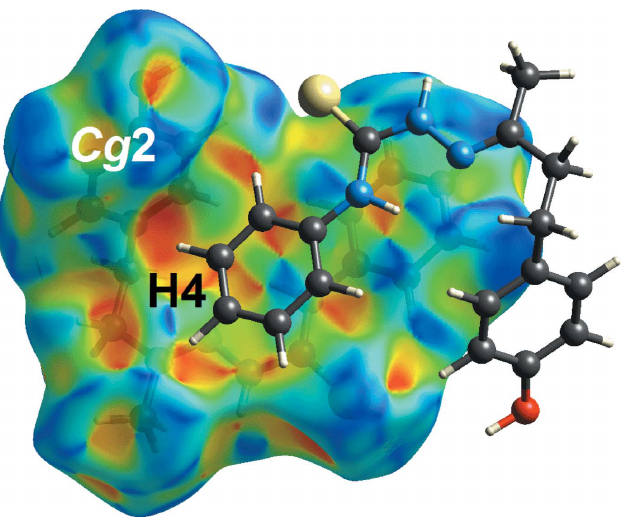
Figure 6 A view of the Hirshfeld surface mapped for (I) over the